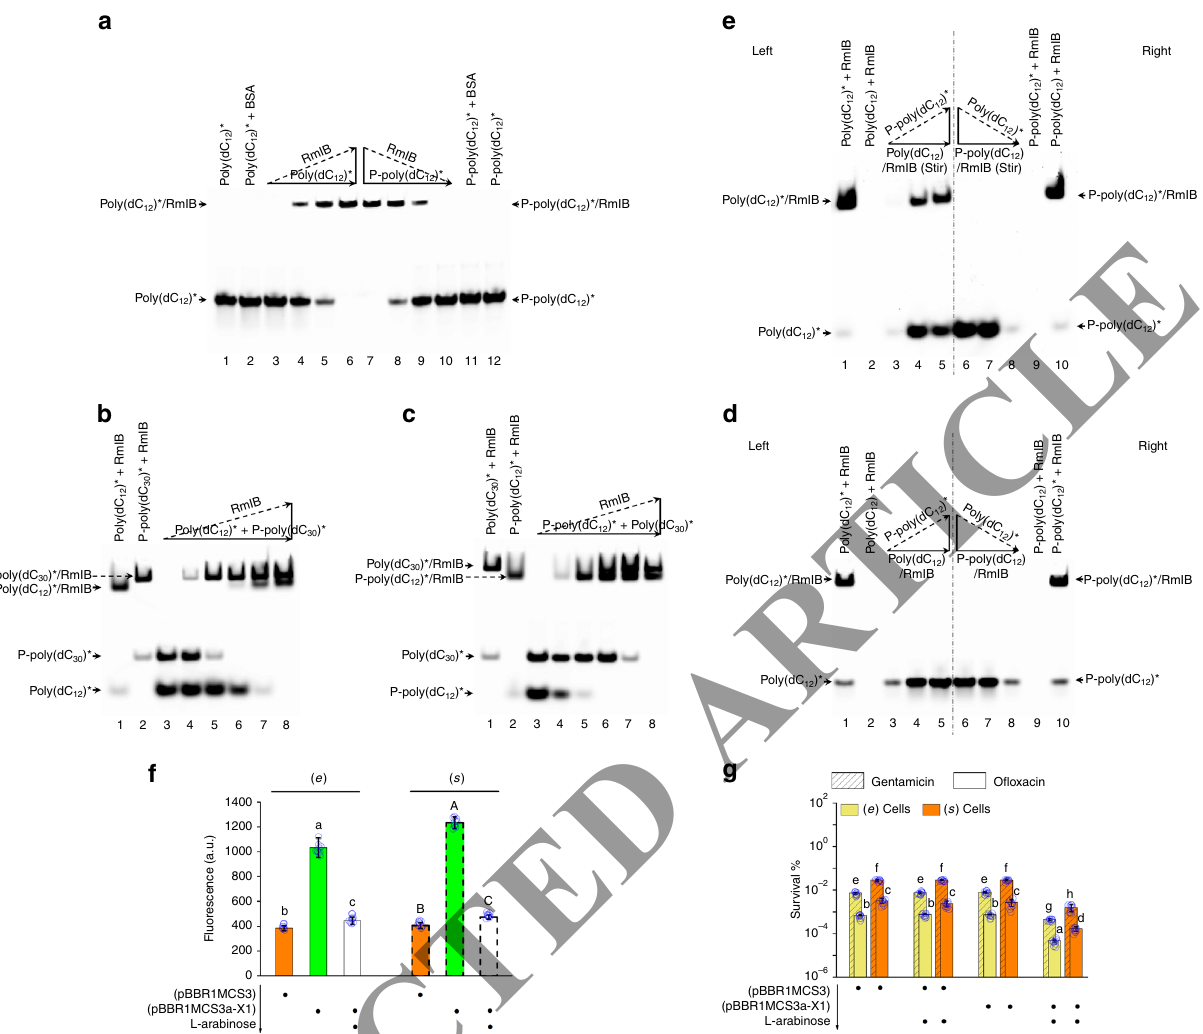
Fig. 2 RmlB controls persistence in PAO1. a Formation of DNA/protein complex by RmlB binding poly(dC 12 )* or P-poly(dC 12 )*. In lanes 3 – 6, a constant concentration of poly(dC 12 )* and an increasing concentration of His-tagged RmlB were mixed together. In lanes 7 – 10, a constant concentration of P-poly (dC 12 )* and a decreasing concentration of His-tagged RmlB were mixed together. b Order of RmlB binding poly(dC 12 )* and P-poly(dC 30 )*. In lanes 3 – 8, a constant concentration of poly(dC 12 )*/P-poly(dC 30 )* mixture and an increasing concentration of His-tagged RmlB were mixed together. c Order of RmlB binding P-poly(dC 12 )* and poly(dC 30 )*. In lanes 3 – 8, a constant concentration of P-poly(dC 12 )*/poly(dC 30 )* mixture and an increasing concentration of His-tagged RmlB were mixed together. d , e Substitutability of ssDNA in poly(dC 12 )/RmlB and P-poly(dC 12 )/RmlB. In lanes 3 – 5, a constant concentration of poly(dC 12 )/RmlB and an increasing concentration of P-poly(dC 12 )* were mixed together with ( e ) or without ( d ) vortex. In lanes 6 – 8, a constant concentration of P-poly(dC 12 )/RmlB and a decreasing concentration of poly(dC 12 )* were mixed with ( e ) or without ( d ) vortex. f Red fl uorescence of cells harboring pBBR1MCS3a-X1 with or without L -arabinose induction. The RmlB fused with mCherry was expressed from a native promoter of rmlB in pBBR1MCS3a-X1. It caused a 2.9-fold increase in fl uorescence as compared to cells harboring pBBR1MCS3. Red fl uorescence was decreased 2.47-fold upon expression of rmlB asRNA from pBBR1MCS3a-X1 with 0.2% L -arabinose induction. The basal level of fl uorescence with the empty vector (pBBR1MCS3) should come from the metabolites of bacteria. a.u. arbitrary units. g Persistence in cells harboring pBBR1MCS3a-X1 with or without L -arabinose induction. Expressing rmlB asRNA with 0.2% L -arabinose induction caused a nearly 24-fold decrease in persistence of the ( e ) or ( s ) cells. All experiments were performed in biological triplicates. Error bars represent standard deviations. Dot plots overlaid on bar graphs represent individual data points. Black spot, treatment step or object; arrow, treatment order ssDNA containing a hairpin structure in 3 ′ terminus and a Cy5 WT cells (Supplementary Fig. 9b). This result indicates that low label (*) attached to 5 ′ terminus (5 ′ -*poly(dC 20 )AAAAAACC molecular weight protein have a critical role in the regulation of persistence. Following analysis of the proteome in the fi nal TTTTTT-3 ′ ) (Fig. 3a). We also observed the expected stimulation fi ltrate, we observed only one potential in-situ switch related of persistence following addition of His-tagged XseB to ( s ) protein, which has been annotated as a putative exonuclease VII WT cells (Fig. 3b). P-poly(dC) was subsequently identi fi ed as the small subunit XseB (8.8 kDa; locus tag, PA4042) (Supplementary unique RmlB-bound component in these cells. On the other Table 4). In the following tests, His-tagged XseB failed to degrade hand, His-tagged XseA, a putative exonuclease VII large subunit Cy5-labeled double-stranded DNA, but did exhibit single strand- (50.5 kDa; locus tag, PA3777), in vitro binds His-tagged XseB to speci fi c 5 ′ → 3 ′ cleavage activity, which resulted in the rapid form a complex that can be trapped by Ultracel-30K Centrifugal disappearance of fl uorescence in both free and RmlB-bound Filter Units (30-kDa cutoff size) (Supplementary Fig. 9c). The NATURE COMMUNICATIONS| (2019) 10:27 |https://doi.org/10.1038/s41467-018-07861-z|www.nature.com/naturecommunications